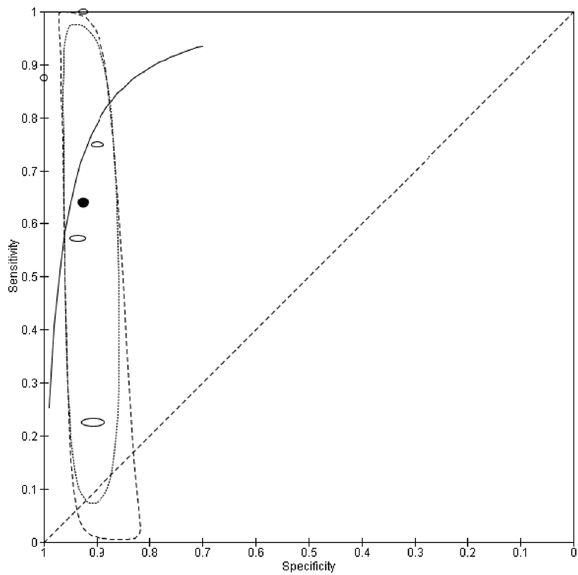
Fig. 6 Random effects bivariate summary receiver operator characteristic curve for photograph based recognition of surgical site infection. Elliptical data points represent weight sensitivity- speci fi city trade-off for each study. The summary point is expressed in the summary curve with dotted line 95% con fi dence region and dashed line 95% prediction region.